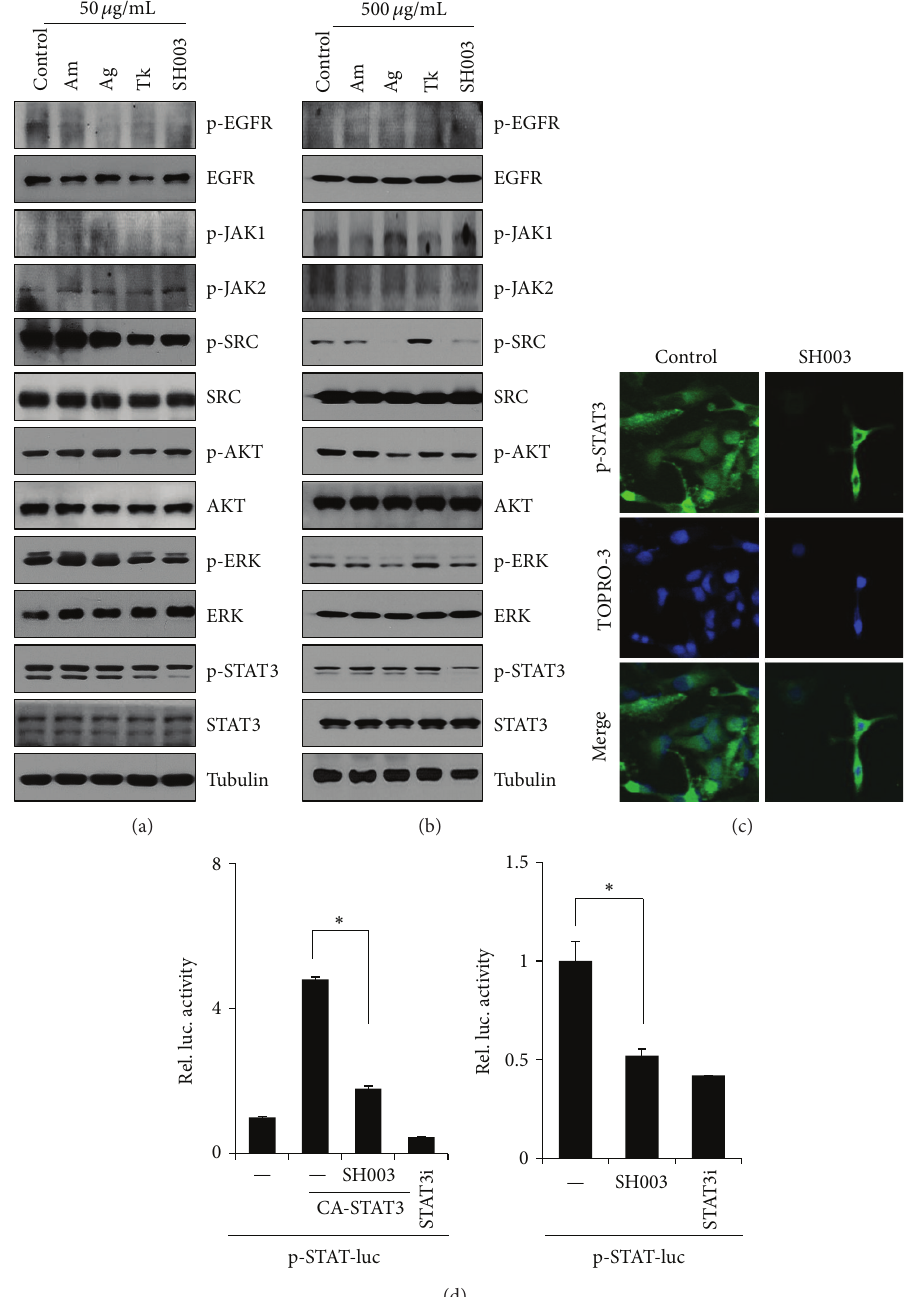
Figure 5: SH003 selectively inhibits STAT3 phosphorylation and transcriptional activity. ((a) and (b)) MDA-MB-231 cells were treated with the indicatives at 50 or 500 𝜇 g/mL for 15 minutes and then subjected to western blots with the antibodies indicated. Tubulin was used for the internal control. (c) Cells were treated with the indicatives for 6 hours and then stained with anti-p-STAT3 antibody (green) and TOPRO-3 (blue). 20x objectives. A scale bar indicates 10 𝜇 m. (d) Representative data for the luciferase assays. 293T (left) and MDA-MB-231 (right) cells were transfected with the indicatives and then treated with each extract for 24 hours. Experiments were performed in triplicate. Bars indicate means and standard deviations. ∗ 𝑃 < 0.05